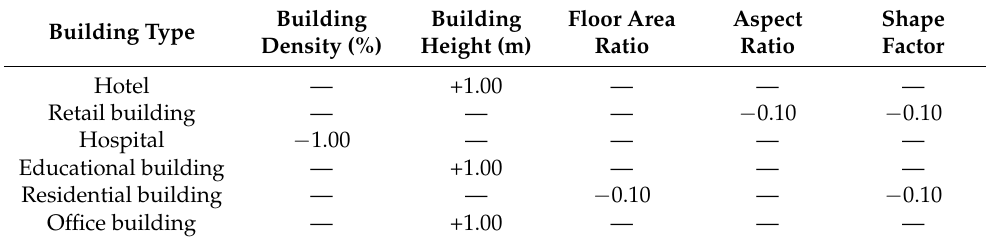
Table 12. Adjustment value of main parameters of urban morphology